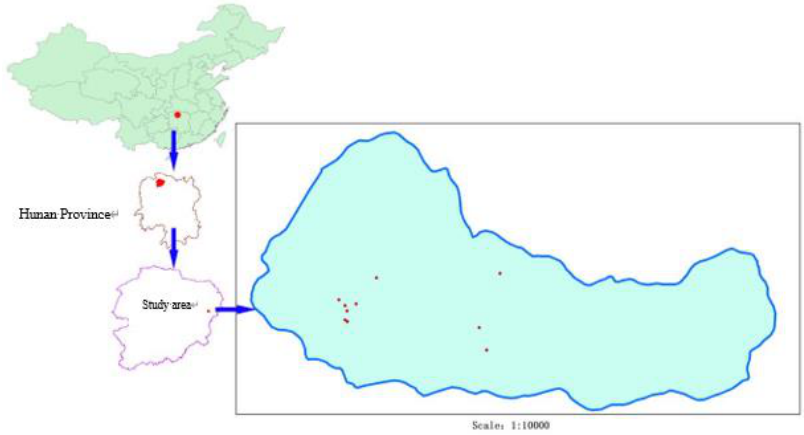
Figure 1. Location of the case study in Hunan Province, China.